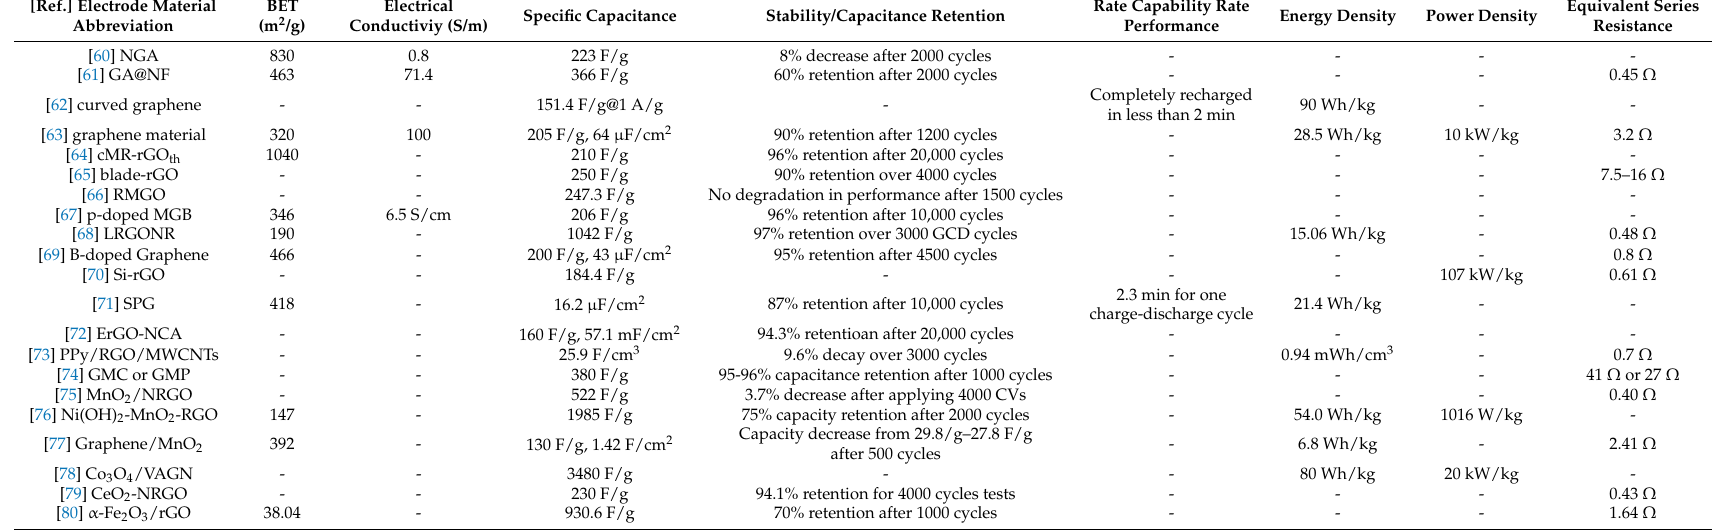
Table 2. Electrode materials that are reviewed and their capacitive